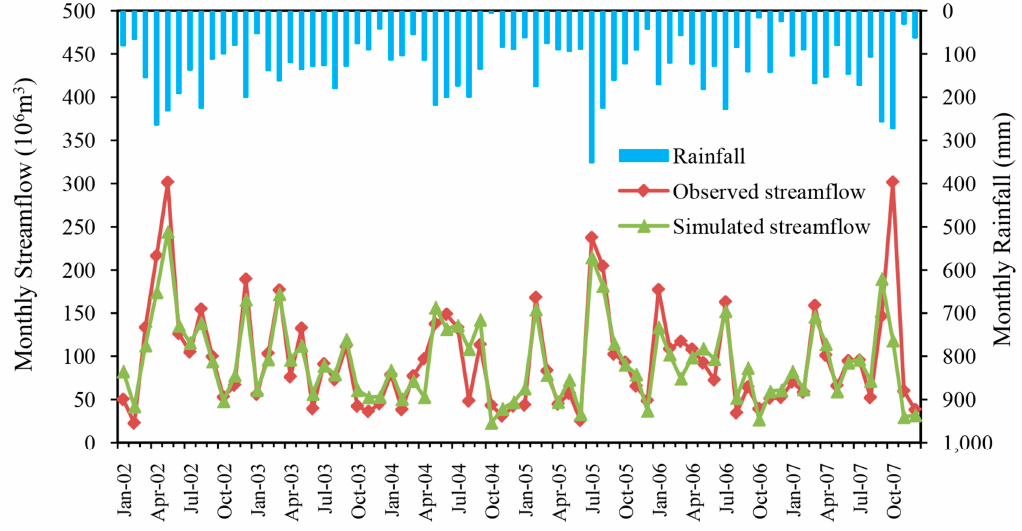
Figure 3. Comparison between simulated and observed monthly streamflow in the Xitiaoxi watershed during the calibration period (January 2002 to December 2007).